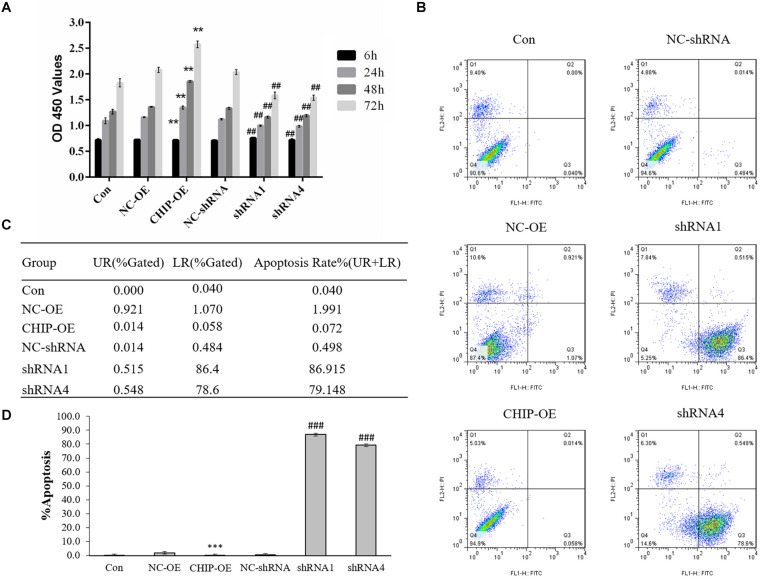
C terminus of Hsc70-interacting protein (CHIP) overexpression promoted bEnd.3 cell growth after stretch-induced injury treatment. (A) CCK-8 assay was used to determine bEnd.3 cell viability. Cells were seeded in Bioflex 6-well plates for 12 h, followed by in vitro stretch-induced injury treatment. After 6, 24, 48, and 72 h, optical density (OD) value was measured at 450 nm. Experiment was performed in triplicate at different times. ∗∗p < 0.01 vs. the NC-OE, ##p < 0.01 vs. the NC-shRNA. (B) Cells were seeded in Bioflex 6-well plates for 24 h, followed by in vitro stretch-induced injury treatment. 5 × 105/ml treated cells were treated and analyzed by fluorescence-activated cell sorting cytometry. For each sample, at least 10,000 cells were analyzed. (C,D) Quantitative statistics of apoptosis rate. ∗∗∗p < 0.001 vs. the NC-OE, ###p < 0.001 vs. the NC-shRNA.